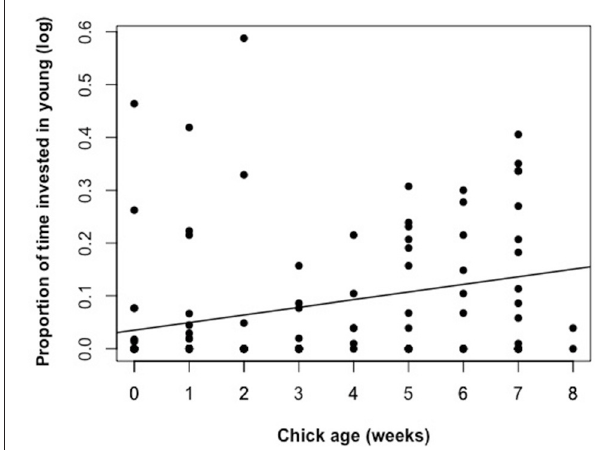
FIGURE 3 | Differences between the average proportions of observation time helpers invested in young according to helper sex per observation session. Error bars generated with ± S.E of the mean.